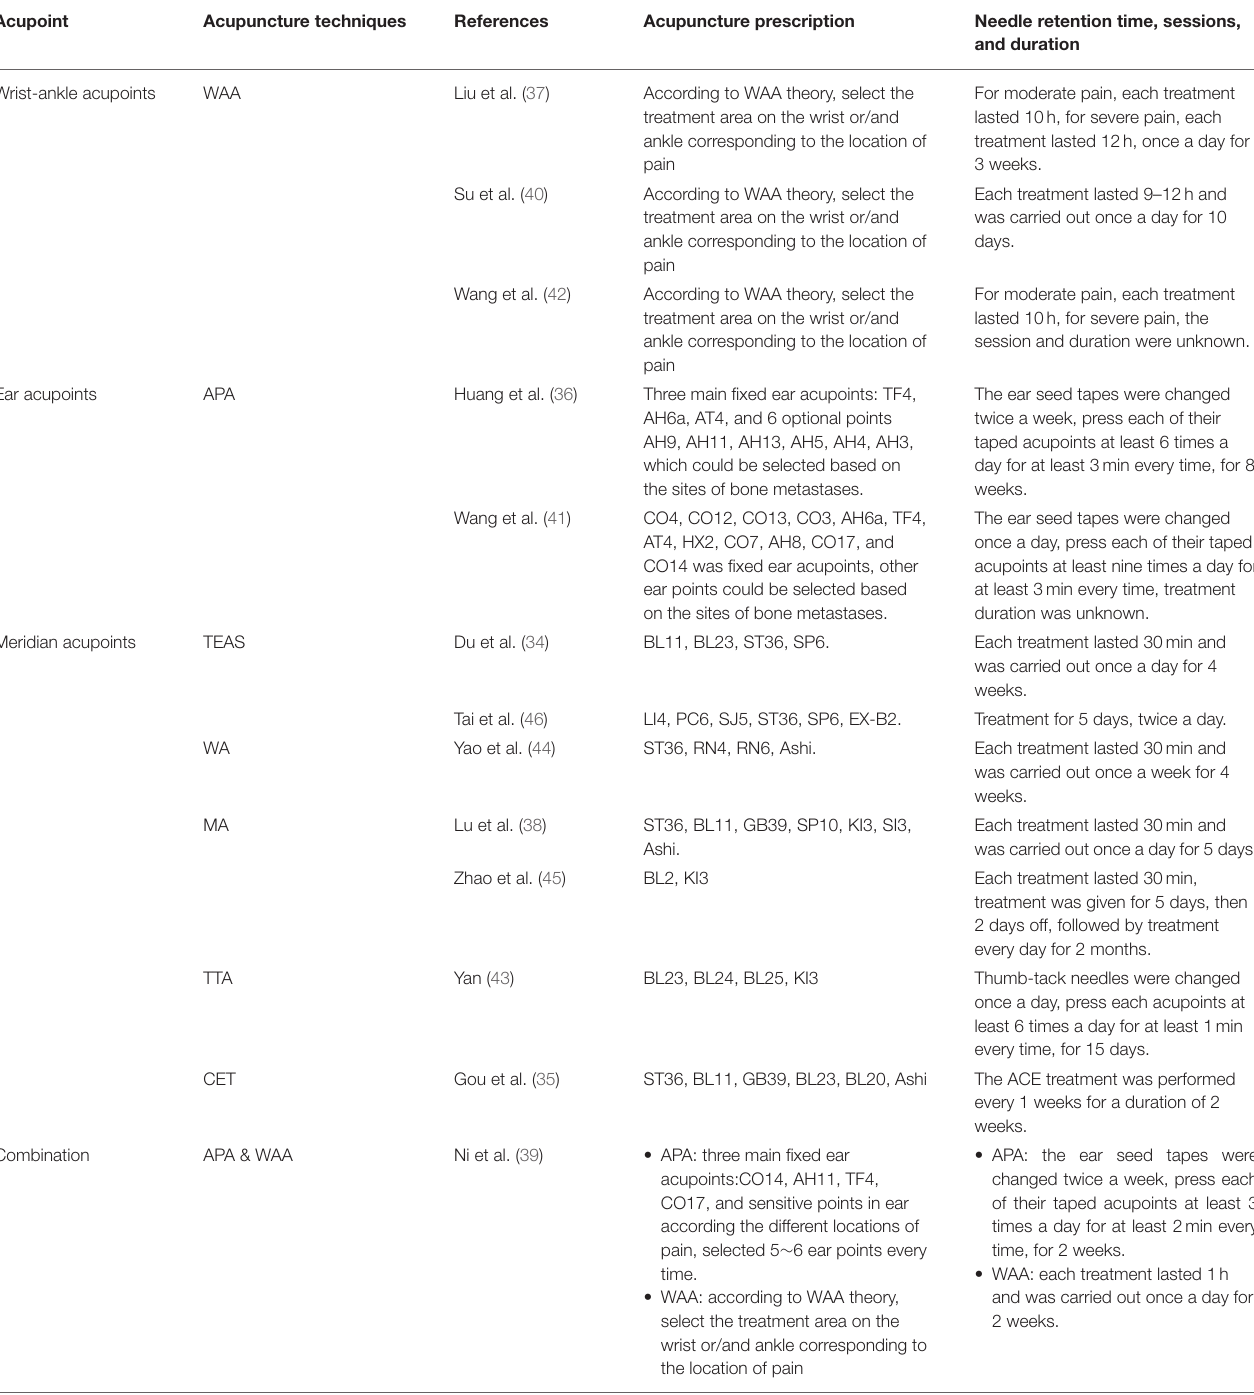
TABLE 1 | The acupuncture techniques and corresponding retention times, number of sessions, and acupuncture